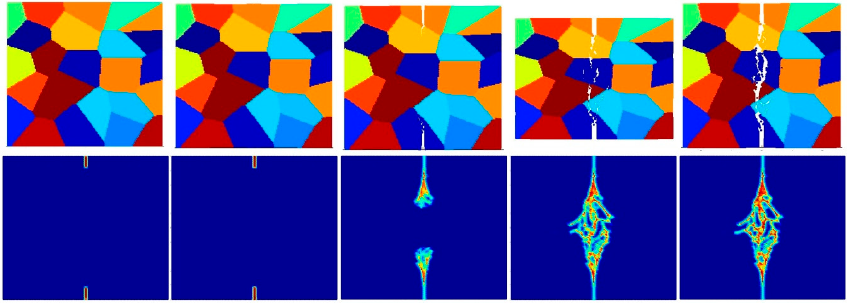
Figure 29. Fracture pattern of polycrystal when β = 2.0 with 25 grains in total. From left to right: time = 1.5 µ s, 2.0 µ s, 2.5 µ s, 3.0 µ s, and 3.5 µ s, respectively.